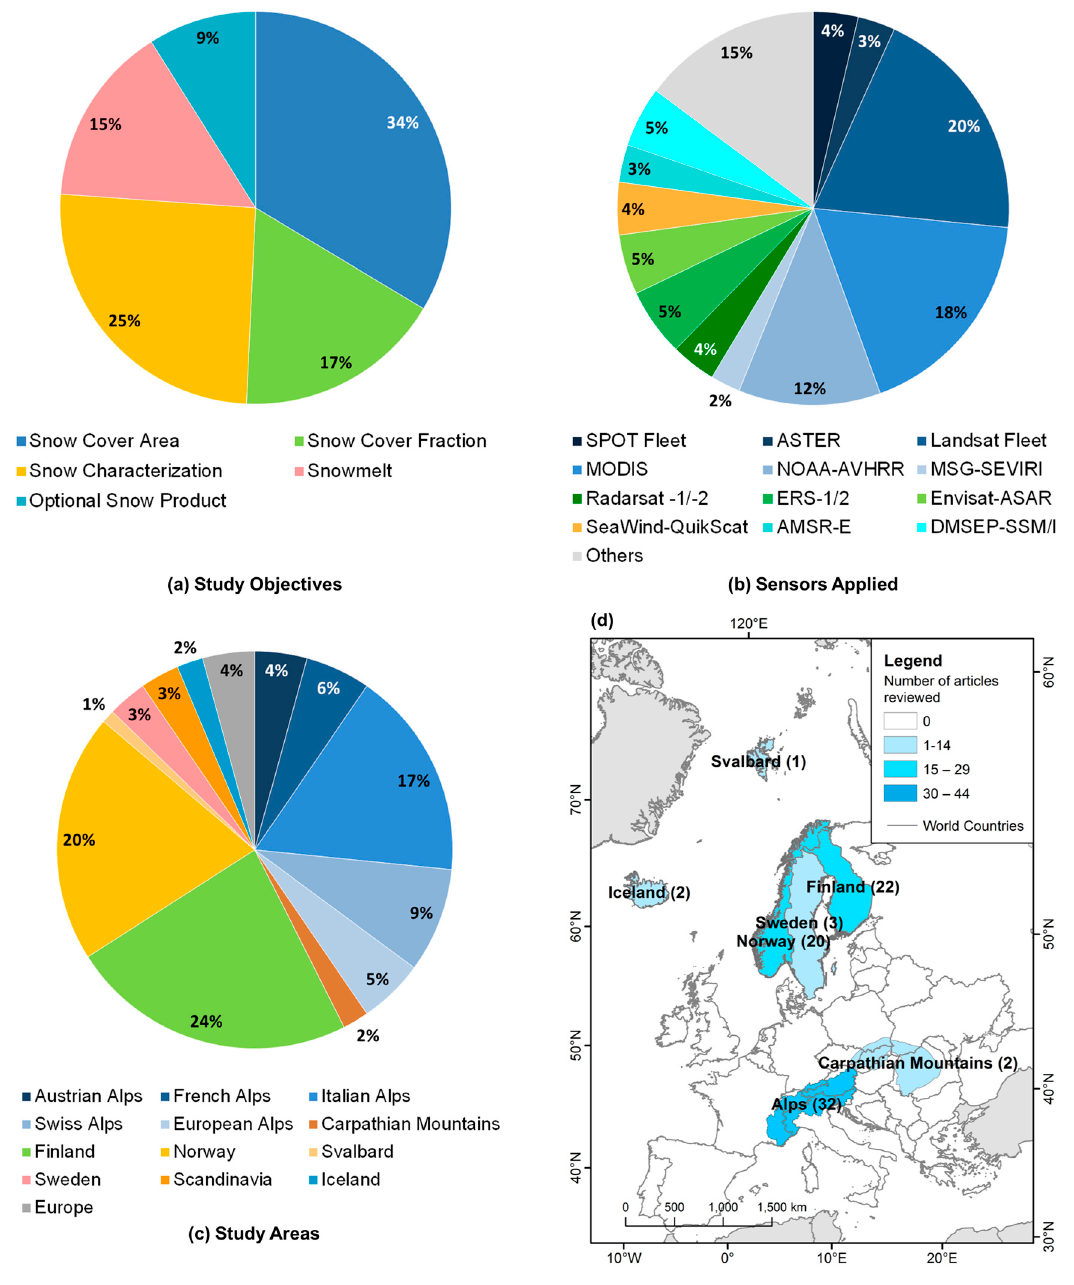
Figure 6. Overview of the reviewed EO-based snow studies published between 1980 and 2016, categorized by ( a ) study objectives, ( b ) applied sensors (sensors used fewer than four times are shown in the class “others”, which includes TerraSAR-X, COSMO-SkyMed, Sentienl-1, ADEOSII-GLI, MERIS, ENVISAT AATSR, GOES, etc.), ( c ) study areas and ( d ) their geographical distribution.